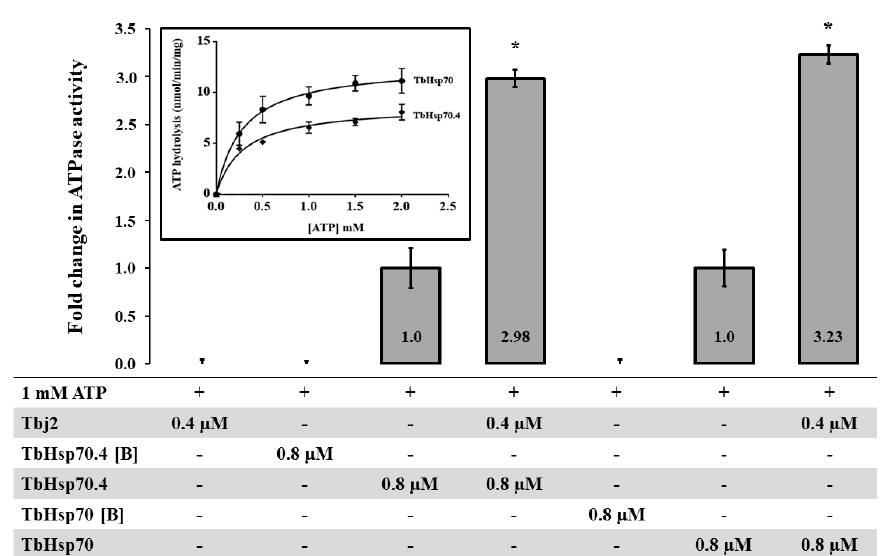
Figure 3. Stimulation of TbHsp70 and TbHsp70.4 ATPase activity by co-chaperone Tbj2. Submolar concentrations of recombinant Tbj2 were used to assess the ability of the co-chaperone to stimulate the basal ATPase activities of TbHsp70 and TbHsp70.4. The inorganic phosphate release was monitored by direct colorimetry at 595 nm wavelength. The curves represent the basal ATPase activities of recombinant TbHsp70 and TbHsp70.4, respectively, expressed as mean (±) SD. The assay was carried out in triplicate from three independent batches of TbHsp70 and TbHsp70.4. ATP hydrolysis by the Tbj2 was also analyzed separately and boiled samples of TbHsp70 and TbHsp70.4, indicated as [B], were included as negative controls. The ‘+’symbols represent components present in a reaction while ‘- ‘represents those that were absent. The averaged data from three independent experiments done in triplicate using three independent batches of purified proteins for each experiment are shown with error bars indicated on each bar to represent standard deviation. Statistically significant di ff erence of the ATPase activity of the TbHsp70s alone relative to the ATPase activity of the TbHsp70s in the presence of Tbj2 are indicated by * ( p < 0.05) above the